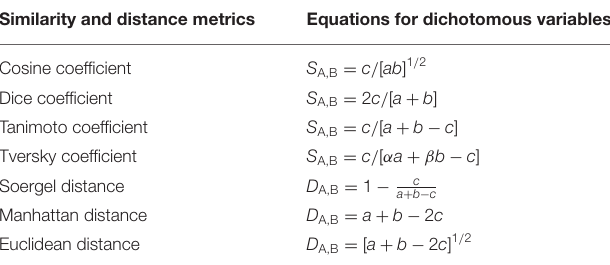
TABLE 2 | Structural similarity and distance metrics applied in virtual